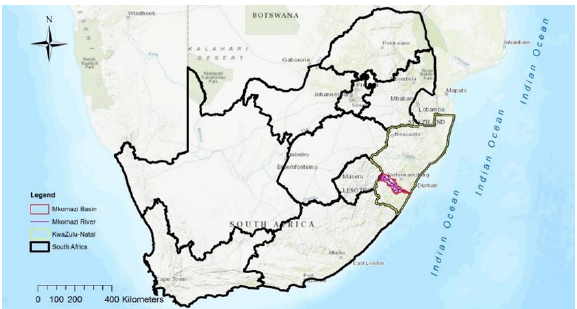
Figure 1. Mkomazi Basin in relation to South Africa Source: ESRI ArcGIS 10.3.1 Software and online web base